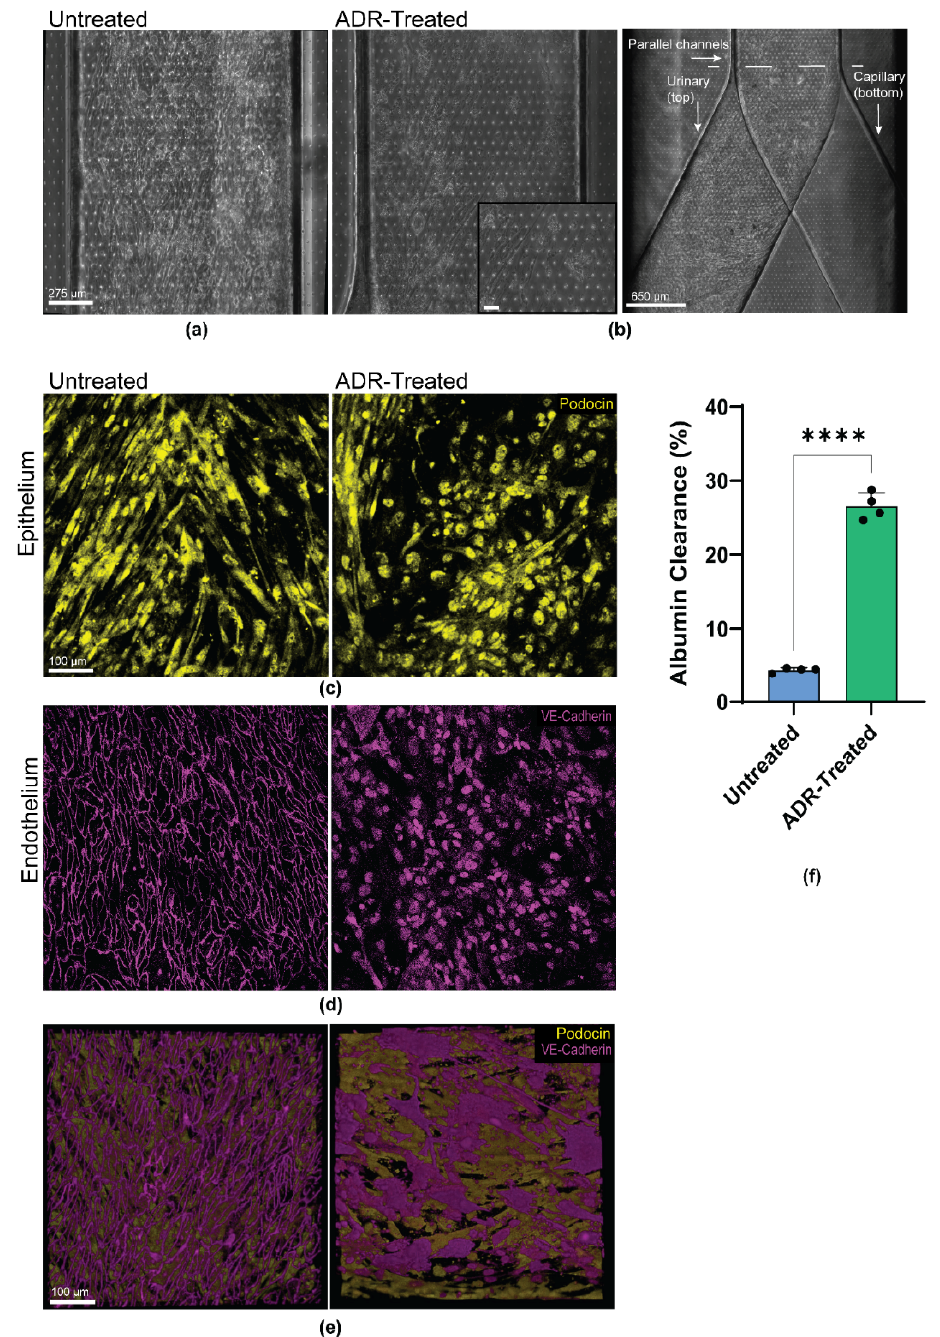
Figure 3. Personalized glomerulus chip recapitulates Adriamycin-induced kidney injury. ( a ) Brightfield images of the glomerular epithelium in the urinary channel of the control/untreated. Scale bar: 275 µ m; ( b ) Brightfield images of the glomerular epithelium in the urinary channel of the treated glomerulus chip after 48 h of Adriamycin. Scale bar: 275 µ m and 650 µ m. Dashed line indicates point where individual channels merge. Inset: Delaminated and effaced podocytes in the urinary channel. Scale bar: 90 µ m; ( c ) Representative confocal microscopy images of the untreated (left) and treated (right) glomerulus chip Podocin positive (yellow) epithelium in the urinary channel. Scale bar 100 µ m; ( d ) Representative confocal microscopy images of the untreated (left) and treated (right) glomerulus chip VE-Cadherin positive (magenta) endothelium in the capillary channel. Scale bar 100 µ m; ( e ) Three-dimensional overlay of Podocin-positive epithelium and VE-Cadherin positive endothelium of the untreated (left) and treated (right) glomerulus chip. Images represent basal to apical view. Scale bar 100 µ m; and ( f ) Quantification of percent albumin clearance from the urinary channel of the glomerulus chip 24 h post Adriamycin treatment compared to the untreated chip. n = 4. **** p = 0.0001 .